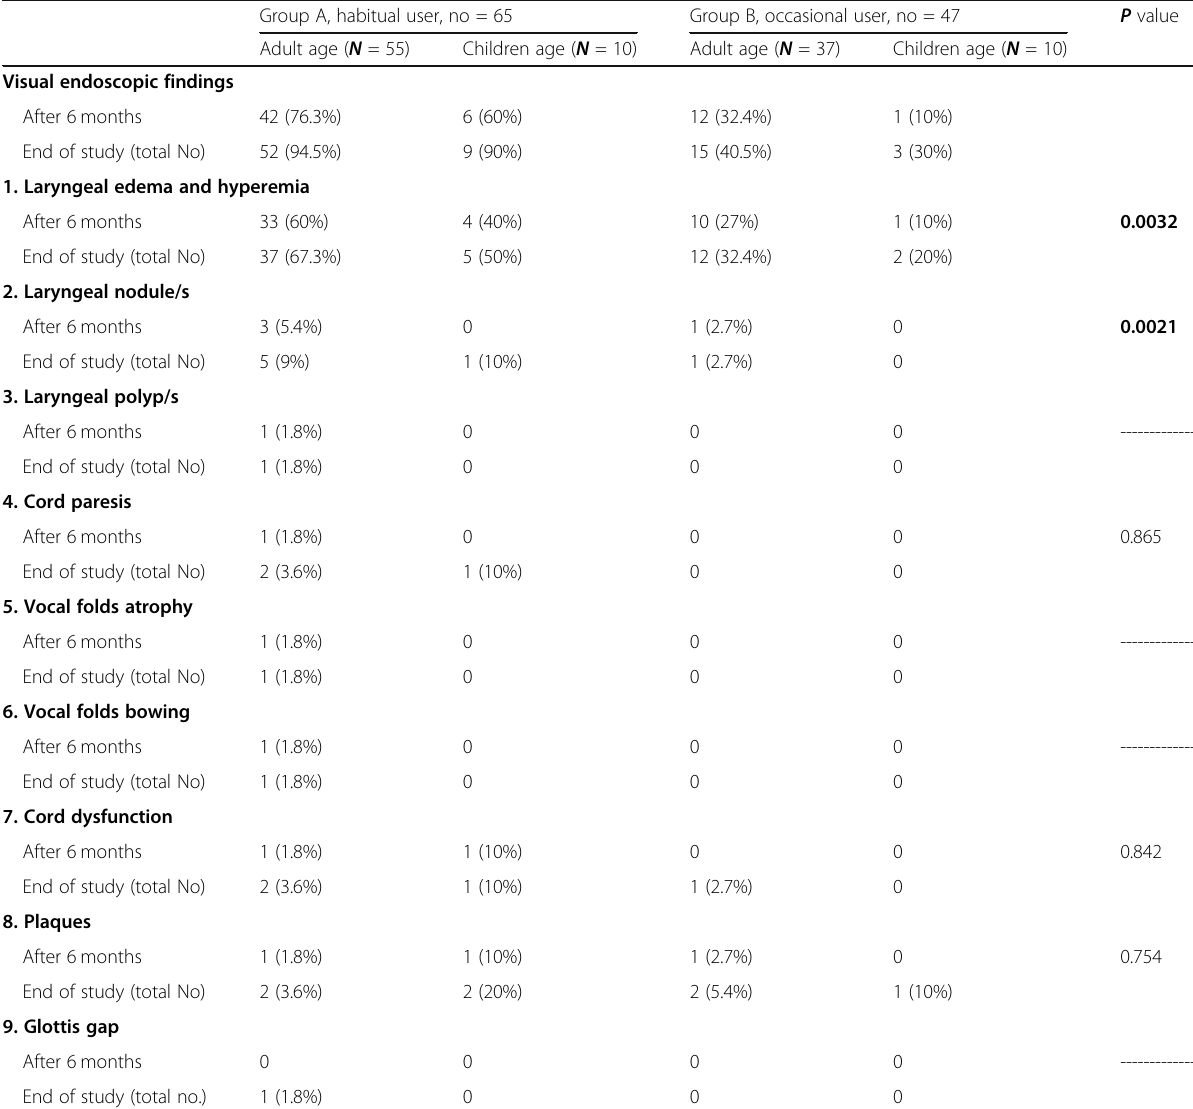
Table 3 Laryngeal endoscopic characters of studied groups Group A, habitual user, no =